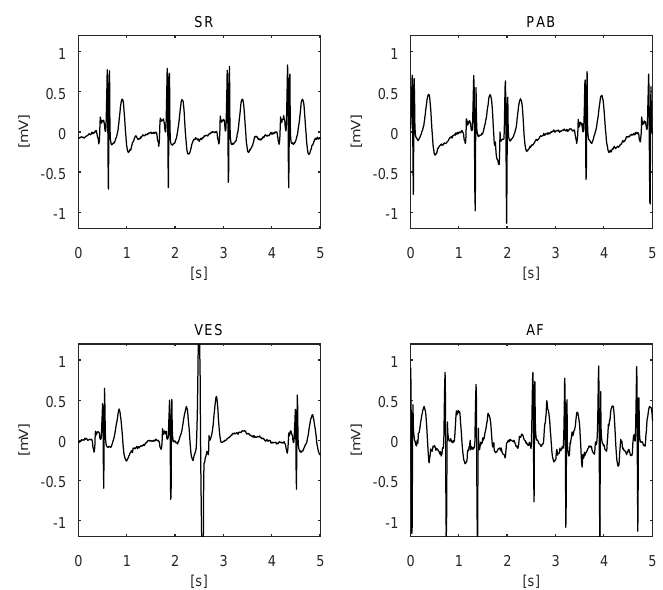
Figure 9. Examples of ECGs with sinus rhythm ( above left ), premature atrial beat ( above right ), ventricular extra systole ( below left ) and atrial fibrillation ( below right